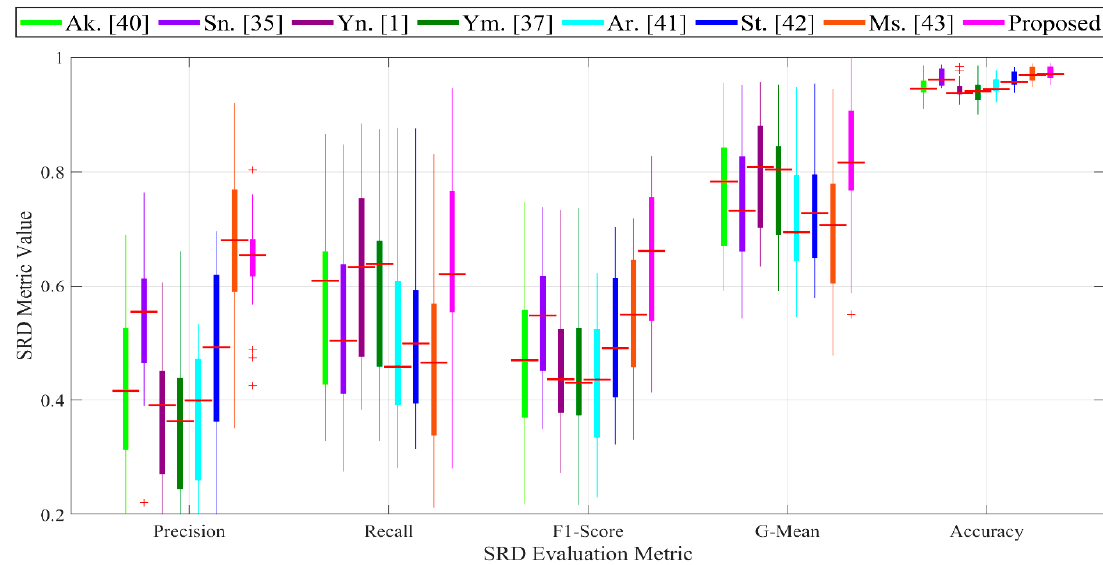
Figure 11. Evaluation results for SRD performances of different methods for maximum specular reflected images of 18 objects in terms of precision, recall, F1-score, G-mean and accuracy.